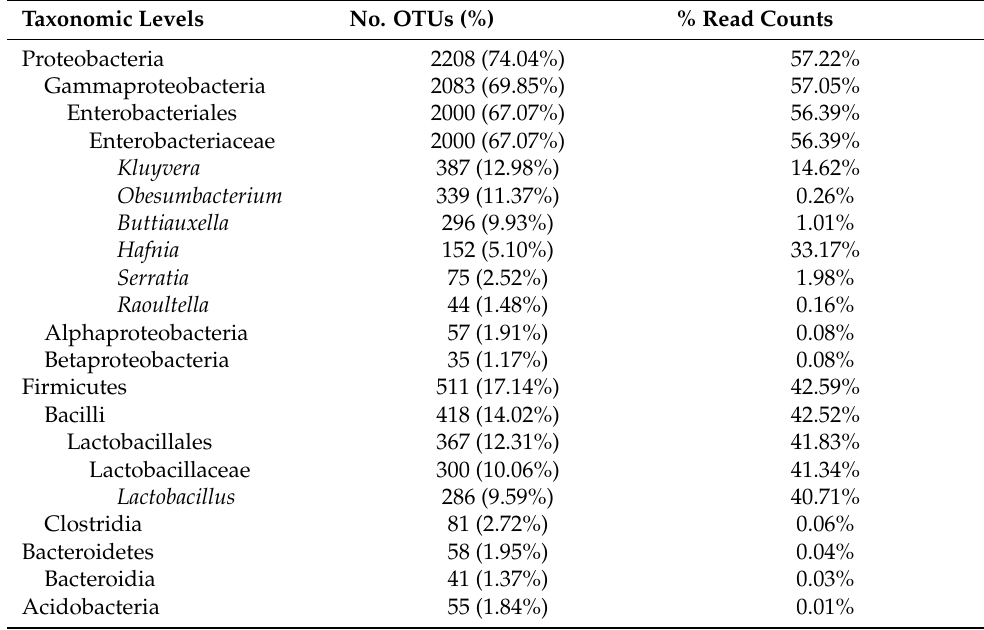
Table 2. No. of OTUs and relative abundance of dominant taxa at different taxonomic